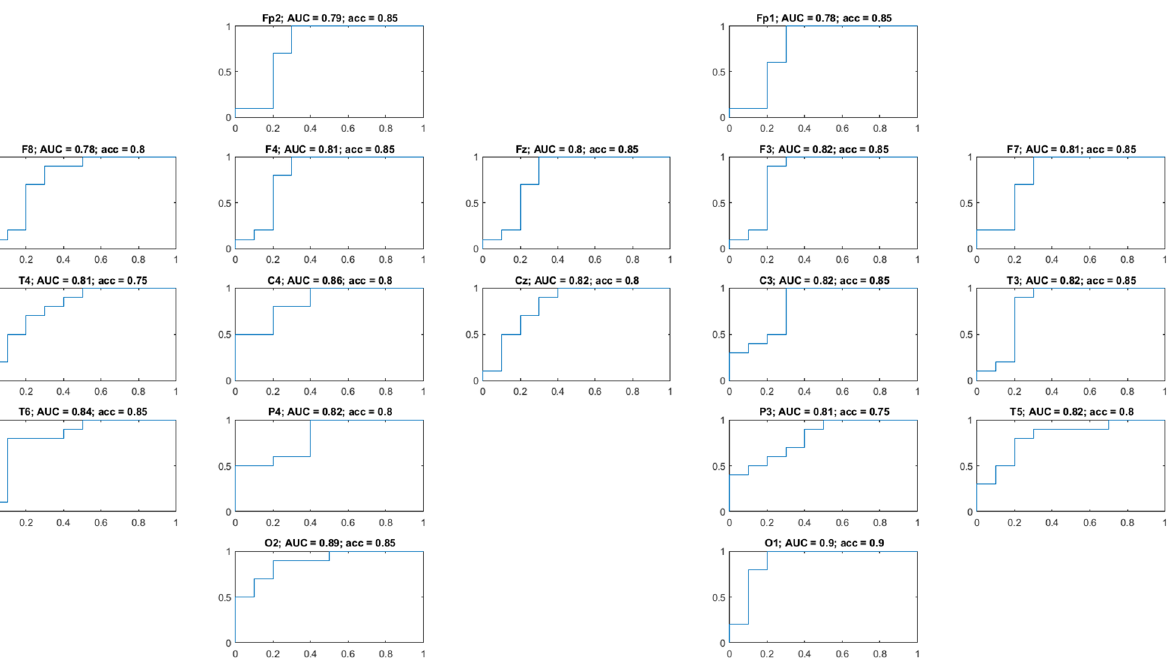
Fig 7. Results of the ROC analysis for all channels. The best channels are O1 and O2 since we want to minimizethe false positive rate while havinga good true positive rate. https://doi.org/10.1371/journal.pone.0184044.g007 PLOS ONE | https://doi.org/10.1371/journal.pone.0184044 September 18,